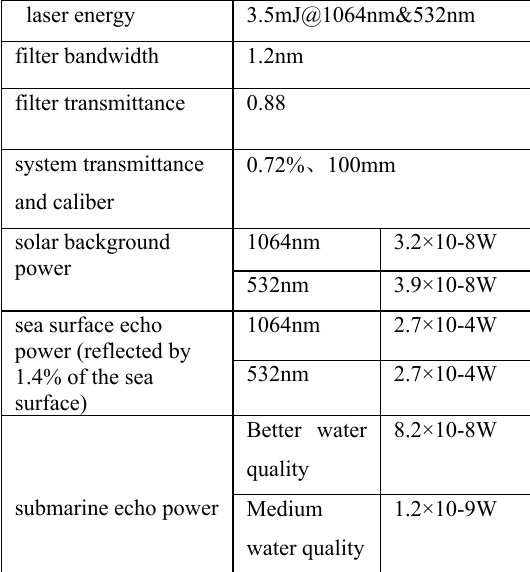
Table 1 Calculation results of solar background power and echo power of different conditions